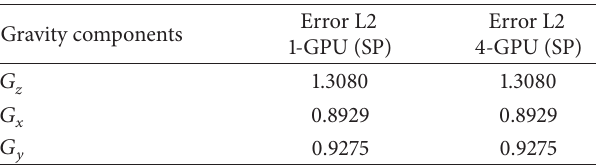
Table 2: Errors of the components of the gravimetric tensor, calculated with CUDAin singleprecision, with respect itssequential counterpart in double precision.